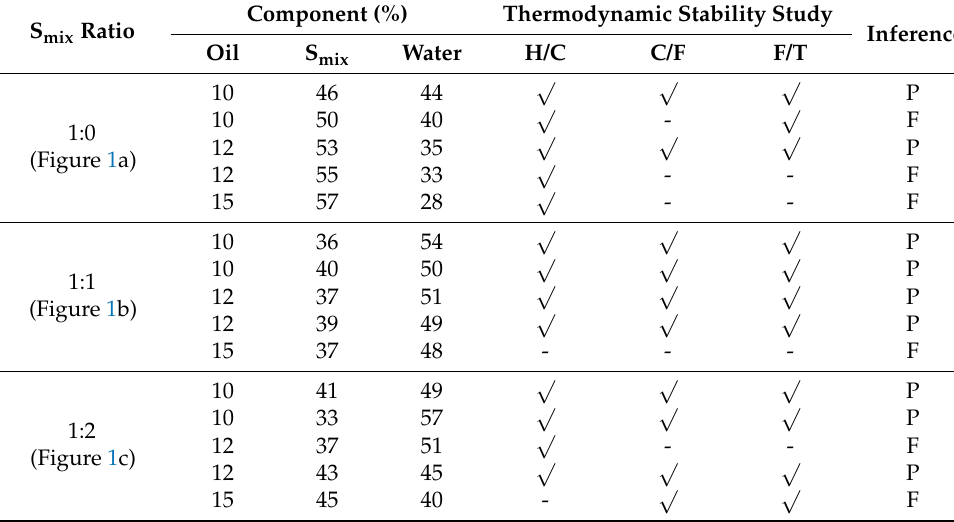
Table 1. Thermodynamic stability evaluation of obtained niaouli essential oil (NEO) nanoemulsions (NEO-NEs). Component (%) Thermodynamic Stability Study S mix Ratio